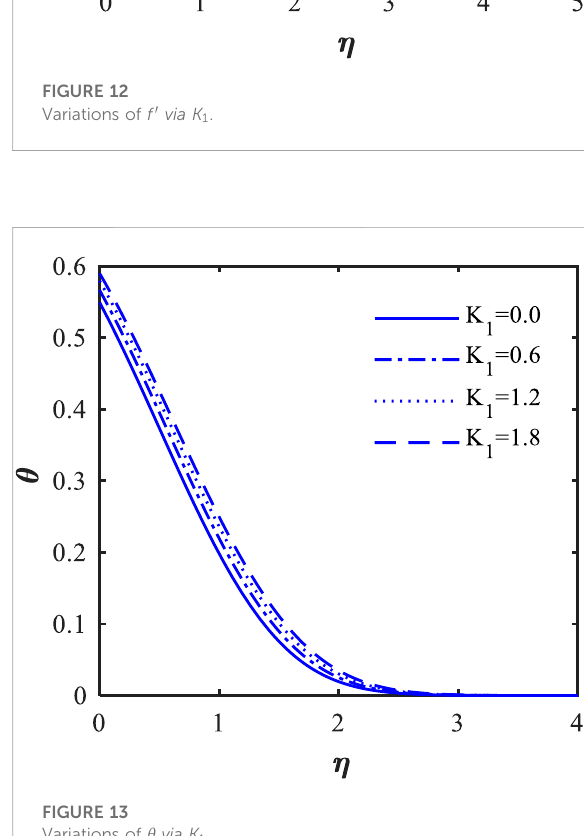
FIGURE 12 Variations of f ′ via K 1 .